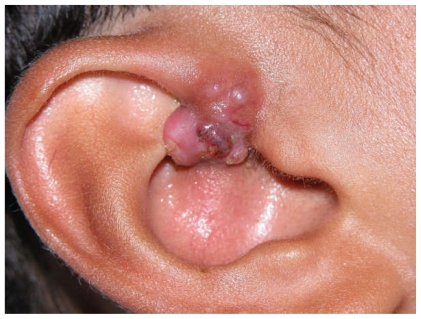
Original leasion.